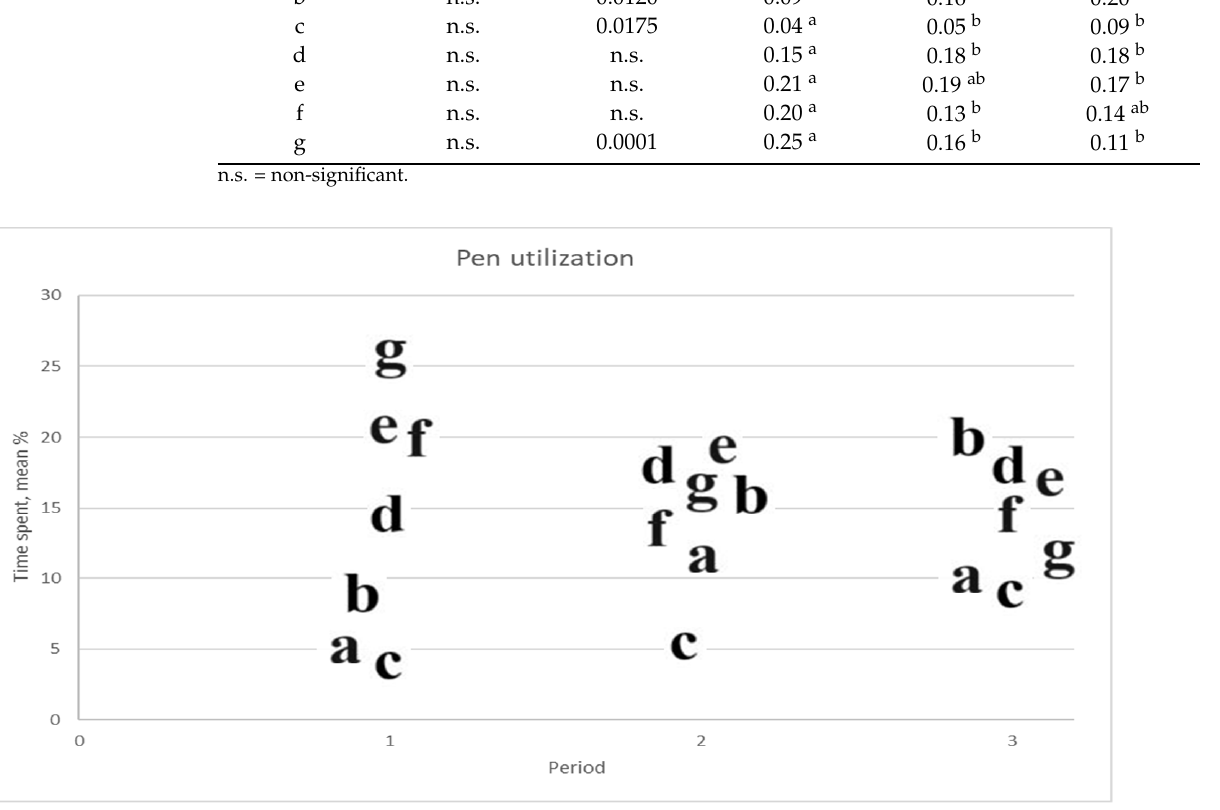
Figure 5. Levels of time spent in the different zones (a–g) of the pen presented as mean percentage. There was no treatment effect on the pen utilization, while the period had an effect on the utilization of zones a, b, c and g. For zones a, b and g, the utilization significantly differed between periods 1 and 2, 3. For zone c, the slatted area, the utilization significantly differed between period 3 and periods 1, 2.